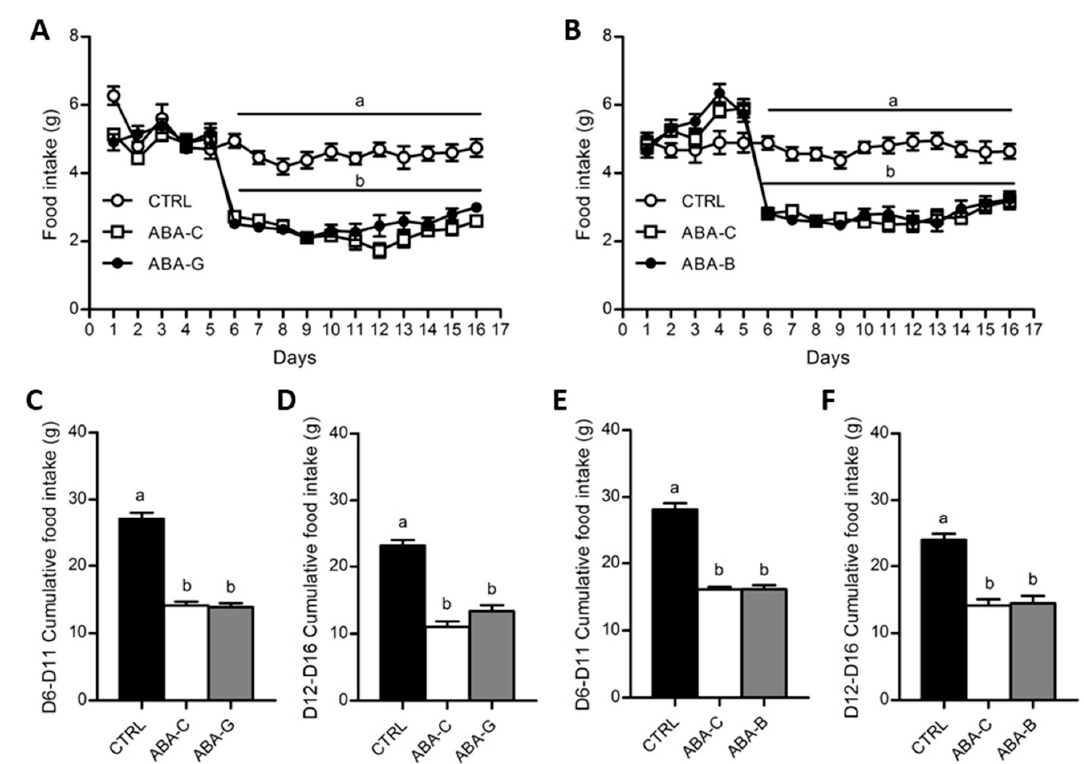
Figure 2. Food intake and cumulative food intake. Food intake was monitored each day, expressed in grams, for both Gln ( A ) and BCAA ( B ) series with control mice (CTRL; open circles), non-supplemented activity-based anorexia mice (ABA-C; open squares) and supplemented activity-based anorexia mice (ABA-G or ABA-B; closed squares). Cumulative food intake, expressed in grams, was calculated from day 6 to day 11 and from day 12 to day 16 (supplementation period) for both Gln ( C , D ) and BCAA ( E , F ) series. Column bar graphs showed control mice (CTRL; black bars), non-supplemented activity-based anorexia mice (ABA-C; open bars) and supplemented activity-based anorexia mice (ABA-G or ABA-B; grey bars). Values without a common letter significantly differ ( p < 0.05). The number of mice was n = 16 for CTRL, n = 16 for ABA-C and n = 12 for ABA-G ( A, C, D ) and n = 16 for CTRL, n = 16 for ABA-C and n = 14 for ABA-B ( B, E, F ).